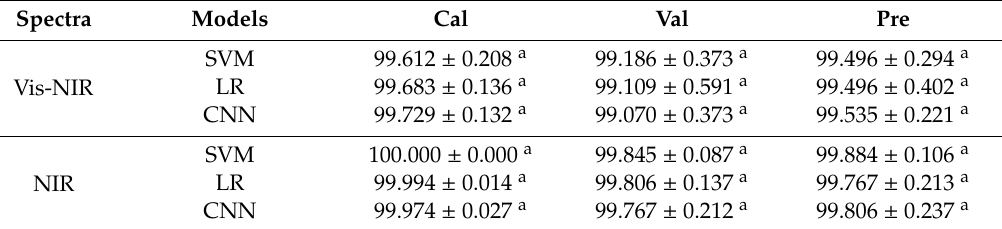
Table 3. The results of the classification models based on deep spectral